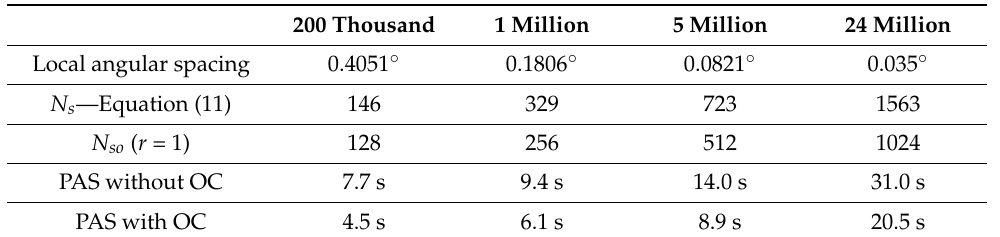
Table 2. Calculated segment size respect to the average point cloud angular spacing for neighboring points and computation time of CGH-PAS without and with occlusion